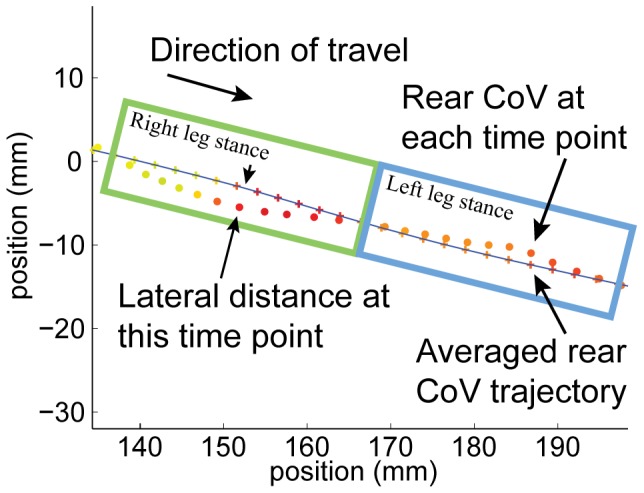
Top-down view of the lateral deviation of the rear CoV during directed locomotion.A top-down view of the rear CoV position in the testing plane at successive points in time (circles, each point is 0.01 s apart) and an averaged rear CoV trajectory (blue line) is shown over one-step cycle lasting 0.24 s. The rear CoV lateral deviation was calculated as the perpendicular distance of the rear CoV position at each point in time from an averaged rear CoV trajectory.